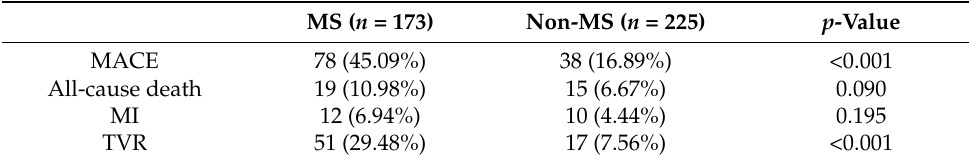
Table 2. Overall number of